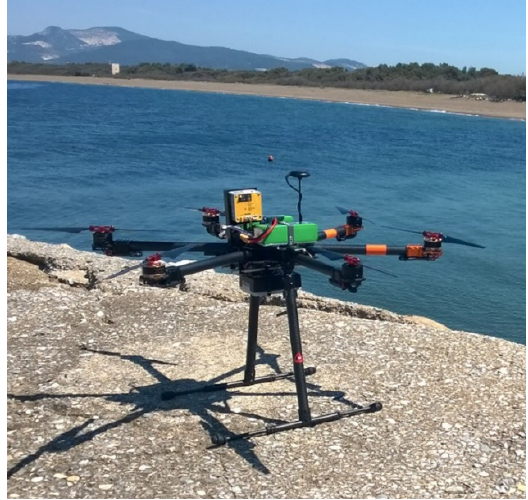
Figure 4. The Unmanned Aerial Vehicle (UAV) used for the survey, equipped with a MAIA multispectral camera.